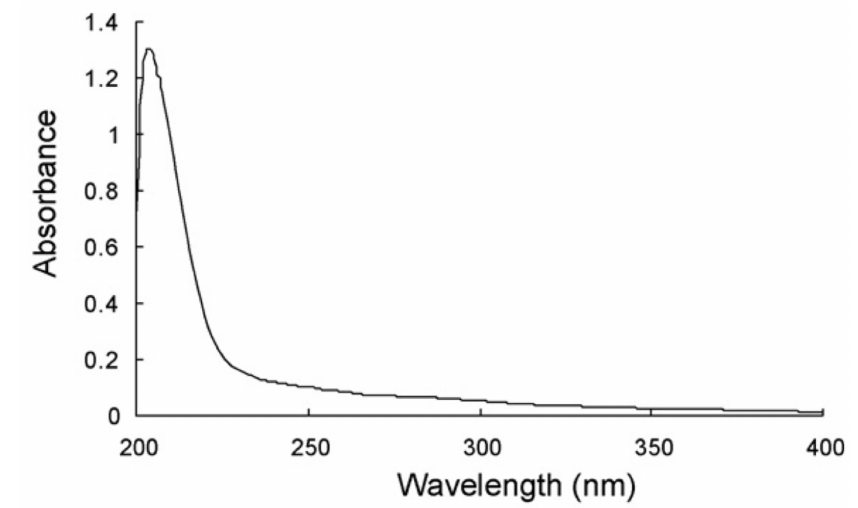
Figure 3. Absorbance spectrum of oleanolic